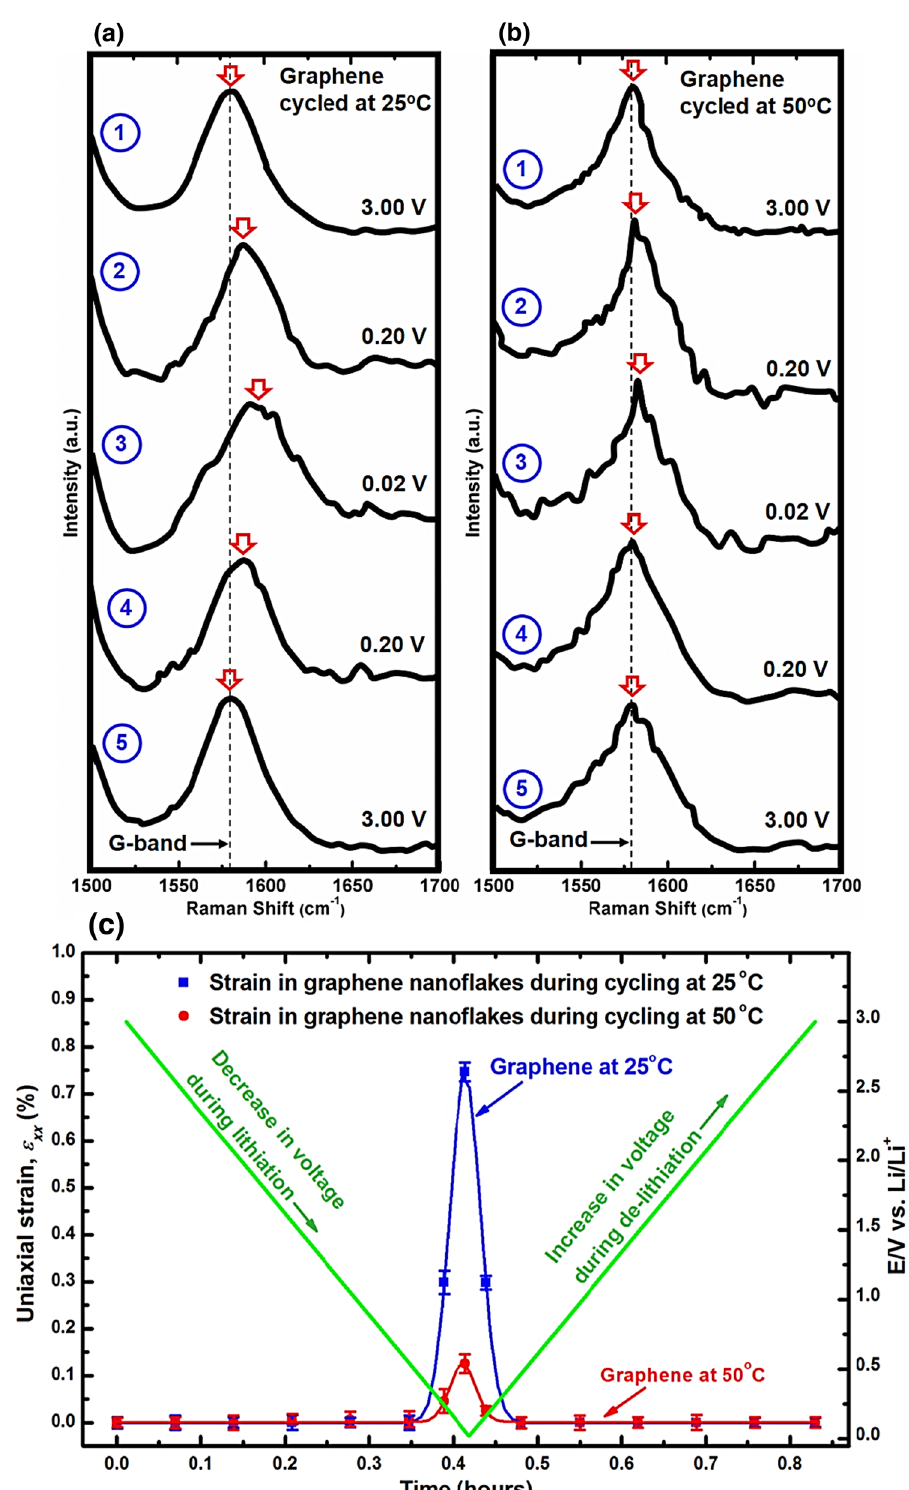
Fig. 8 In-situ Raman spec- tra obtained from graphene nanoflake-based anodes cycled at a 25 °C and b 50 °C, while scanning from 3.00 → 0.02 → 3.00 V at a scan rate of 2.00 mV s −1 . c Plot showing changes in the uniaxial strain measured from the shift in the Raman G-band observed in a ,